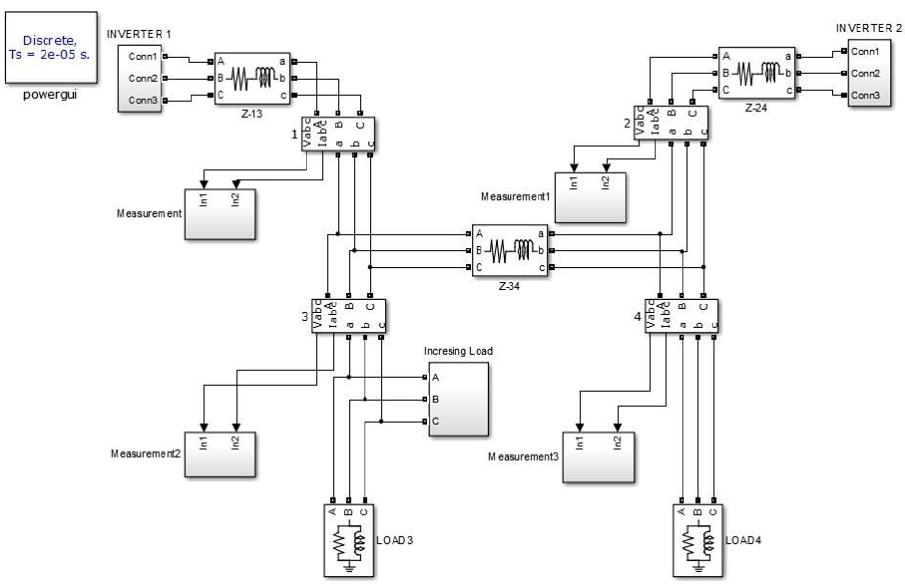
Figure 7. Test Figure 7. Test microgrid.